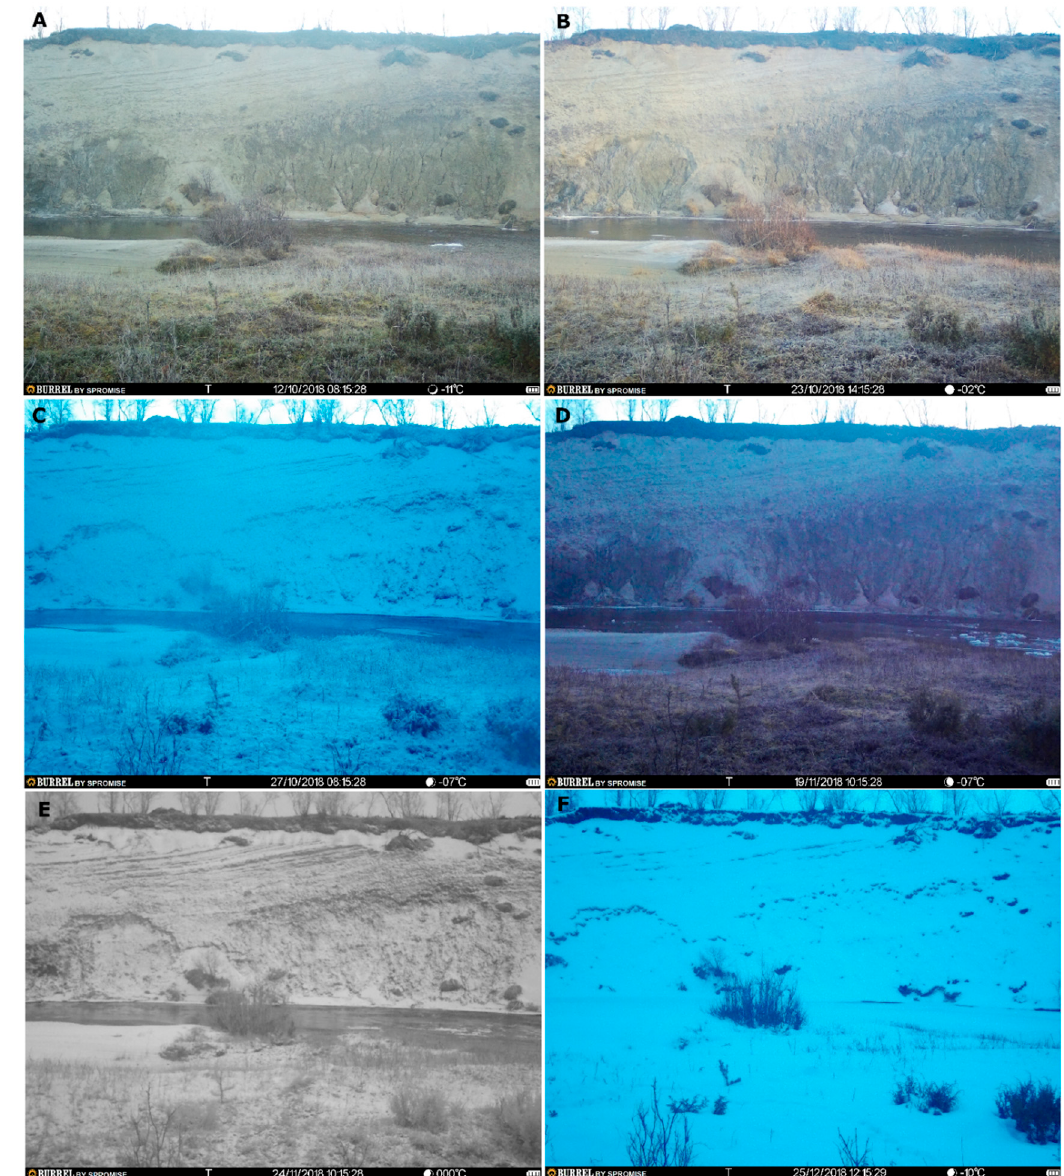
Figure 7. The ice cover development during 2018 autumn. ( A ) 12 October 2018 (at 8:15): There is now for the first time clearly frazil ice/ice rafts /ice clumps floating in the river. At 10:25:28, the amount even increased. ( B ) 23 October 2018 (at 14:15): Couple of ice rafts appear in the river. During the following night, it is − 11 degrees. ( C ) 27 October 2018 (at 8:15): border ice starts to appear for the first time next to point bar and the mid-channel bar. This is the first year (of the whole period 2015–2019) where border ice develops and not just frazil ice/clumps of ice pile on the bars. ( D ) 19 November 2018 (at 10:15): for the third time, there is frazil ice/ice clumps/ice rafts floating on the river. The previous night had been around − 8 degrees. ( E ) 24 November 2018 (at 10:15): Frazil ice/ice clumps/ice rafts are floating on the river again. The ice has started to pile up on the mid-channel bar. ( F ) 25 December 2018 (at 12:15): Full ice cover appears for the first time this autumn. The ice will slightly melt at the outer bank side after this time step, before the full ice cover comes back on 8 January 2019 and stays until the late winter/spring melting periods.